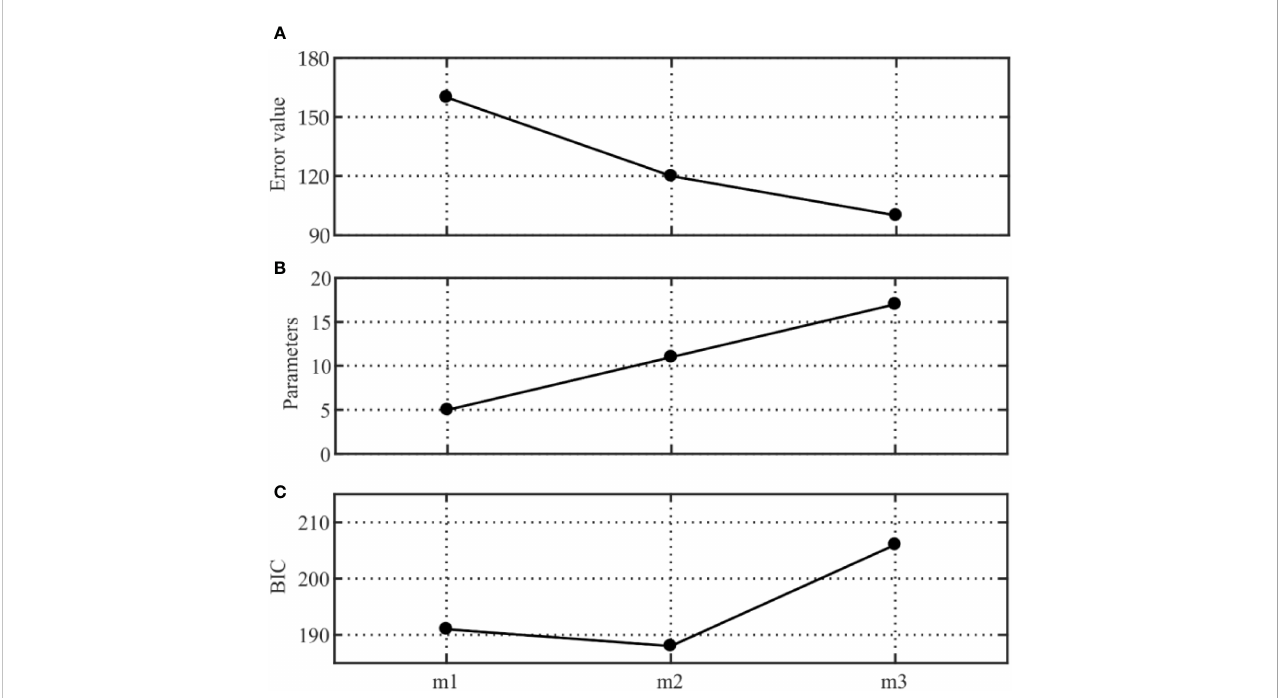
FIGURE 10 Results of the model selection study: (A) Error value, (B) parameters, and (C) BIC, where m 1 , m 2 , and m 3 represent the inversion model of the one-, two-, and three-layer uniformly distributed seabed, respectively.